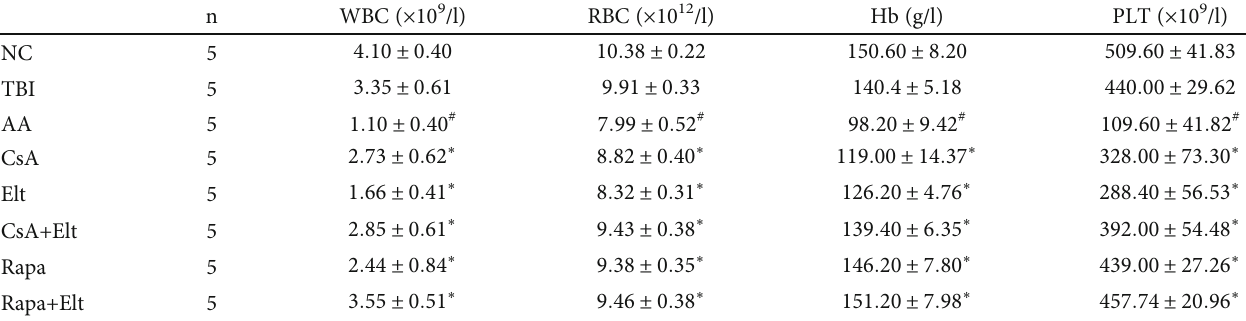
Table 1: Analysis of blood cell count of mice in each group on the 17th day ( − X ± SD ). n WBC ( × 10 9